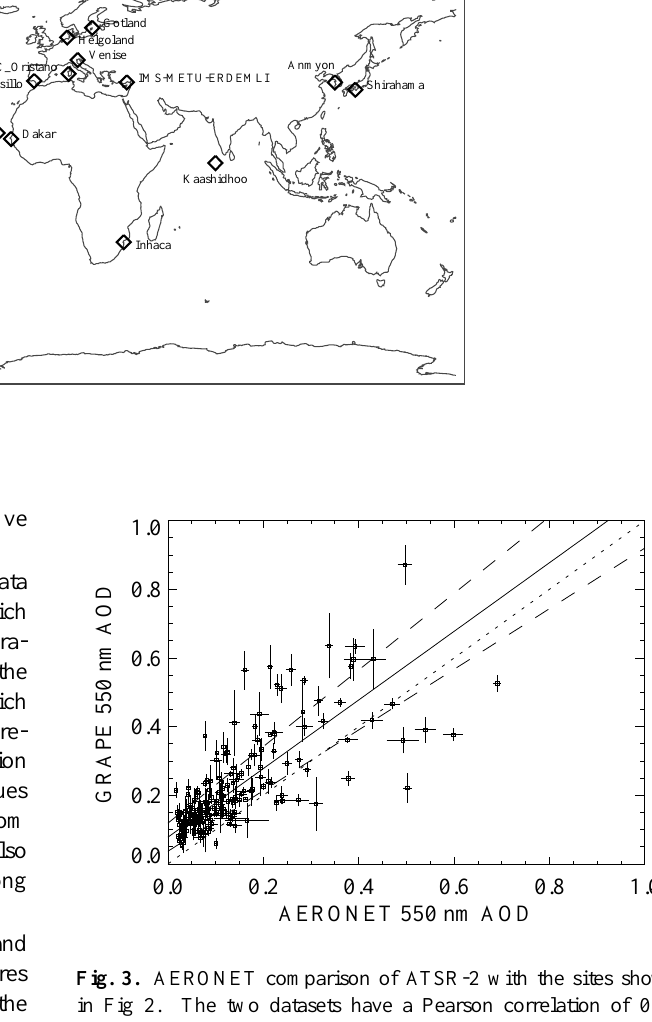
Fig. 3. AERONET comparison of ATSR-2 with the sites shown in Fig 2. The two datasets have a Pearson correlation of 0.79 with an RMS difference of 0.13. The best-fit line (solid line, 1 σ uncertainty given by dashed line) is given by the equation τ G = (0 . 08 ± 0 . 04)+(1 . 0 ± 0 . 1) τ A . Theone-to-one line(dotted) isalso included for reference.